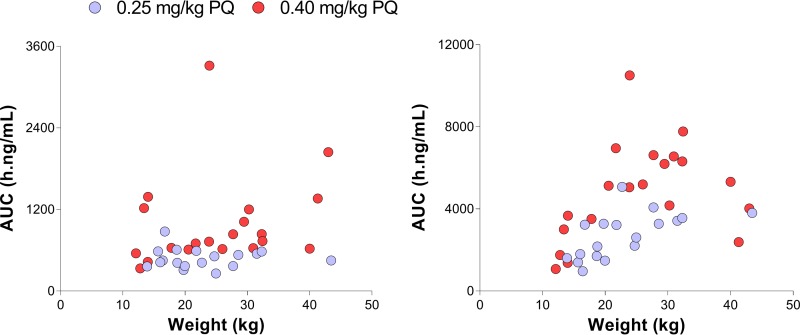
Area under the plasma concentration-time curves for PQ (left panel) and C-PQ (right panel) by weight (x axes).